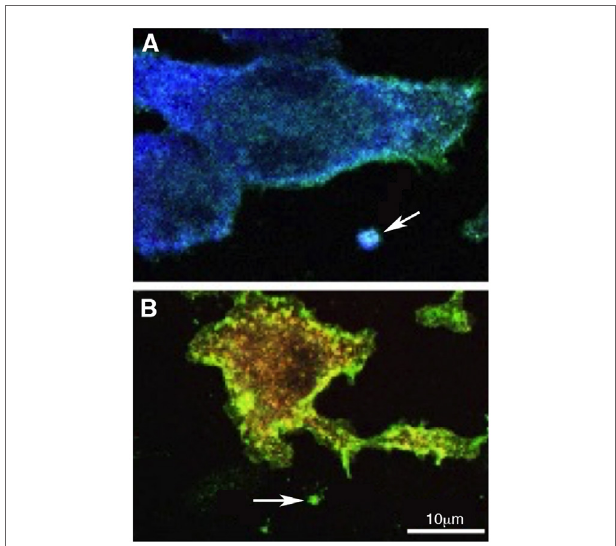
FiGURe 2 | Polarized myeloid cells release polarized microvesicles. Murine macrophages were polarized in the presence of IFN- γ [M1 (A) ] or IL-4 [M2 (B) ] and stained with anti-IB4 (green), anti-Iba-1 (blue), anti-CD206 (red), and DAPI (gray). IB4 stains all myeloid cells, Iba-1 is an M1 marker and is up-regulated in (A) while CD206, an M2 marker, is up-regulated in (B) . Arrows in (A,B) indicate putative shed vesicles (of approximately 1 μ m of diameter) displaying polarization markers similar to